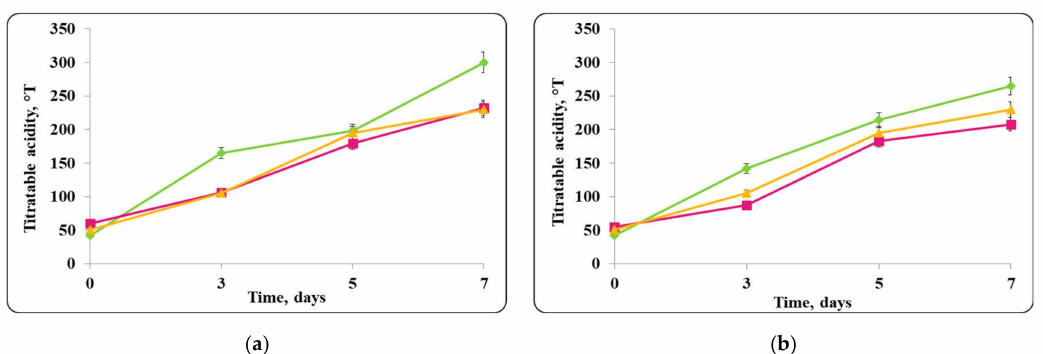
Figure 17. ( a ) free lactobacilli cells; ( b ) encapsulated lactobacilli cells. Changes in the total titratable acidity (TA) of MRS broth inoculated with Lb. helveticus 2/20 and S. aureus ATTC 25923 during storage at 20 ± 2 ◦ C. Legend: Green (cid:117) : TA of MRS broth inoculated with Lb. helveticus 2/20; Pink (cid:4) : TA of MRS broth mousse co-inoculated with Lb. helveticus 2/20 and S. aureus ATCC 25923; Yellow (cid:78) : TA of MRS broth inoculated with S. aureus ATCC